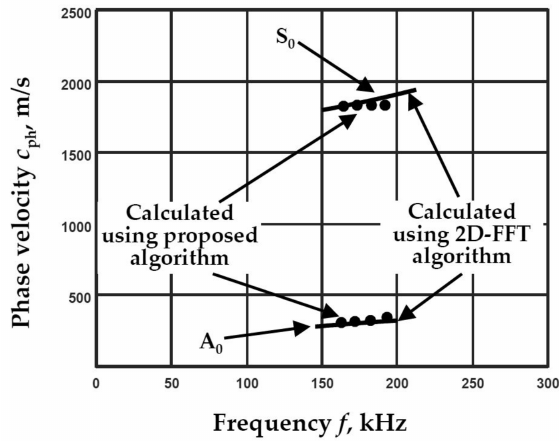
Figure 10. The.reconstructed phase velocities of the A 0 and S 0 modes using the proposed algorithm (dots) and by calculating peak values of spectrum magnitude from 2D-FFT (line).